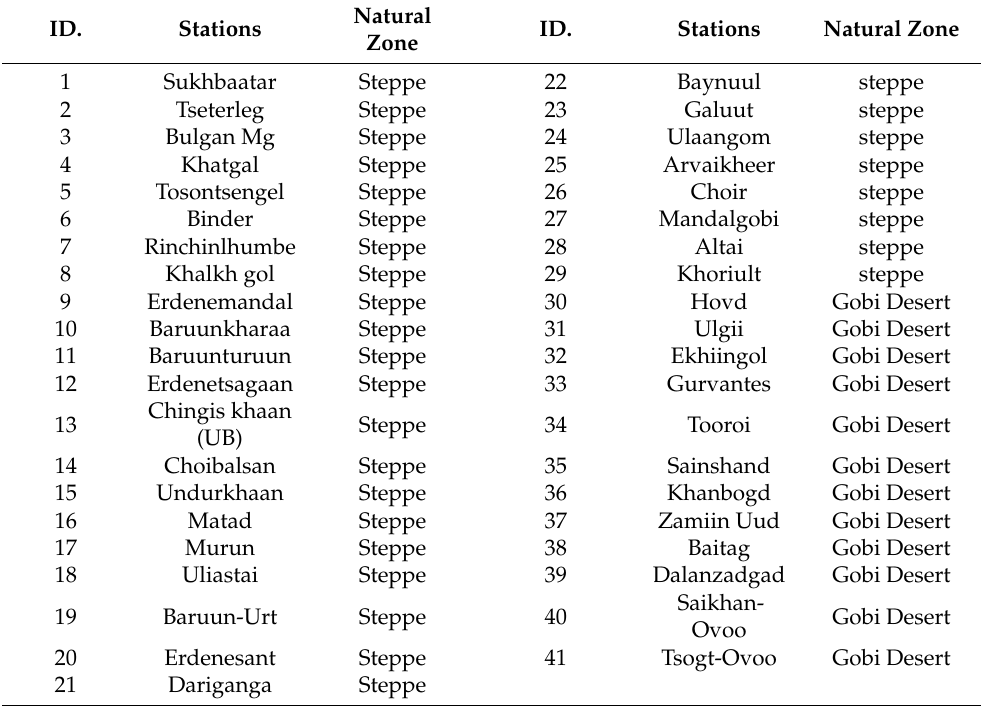
Table A1. Categorization of natural zones.